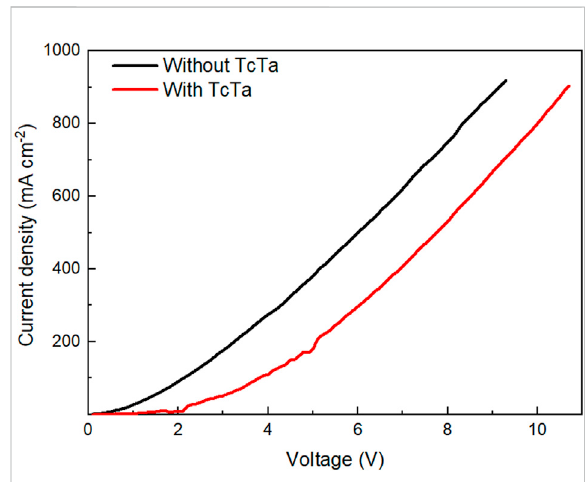
FIGURE 5 Currentdensity-voltage( J-V )characteristicsofthehole-only devices with TcTa or without TcTa doped in EML.